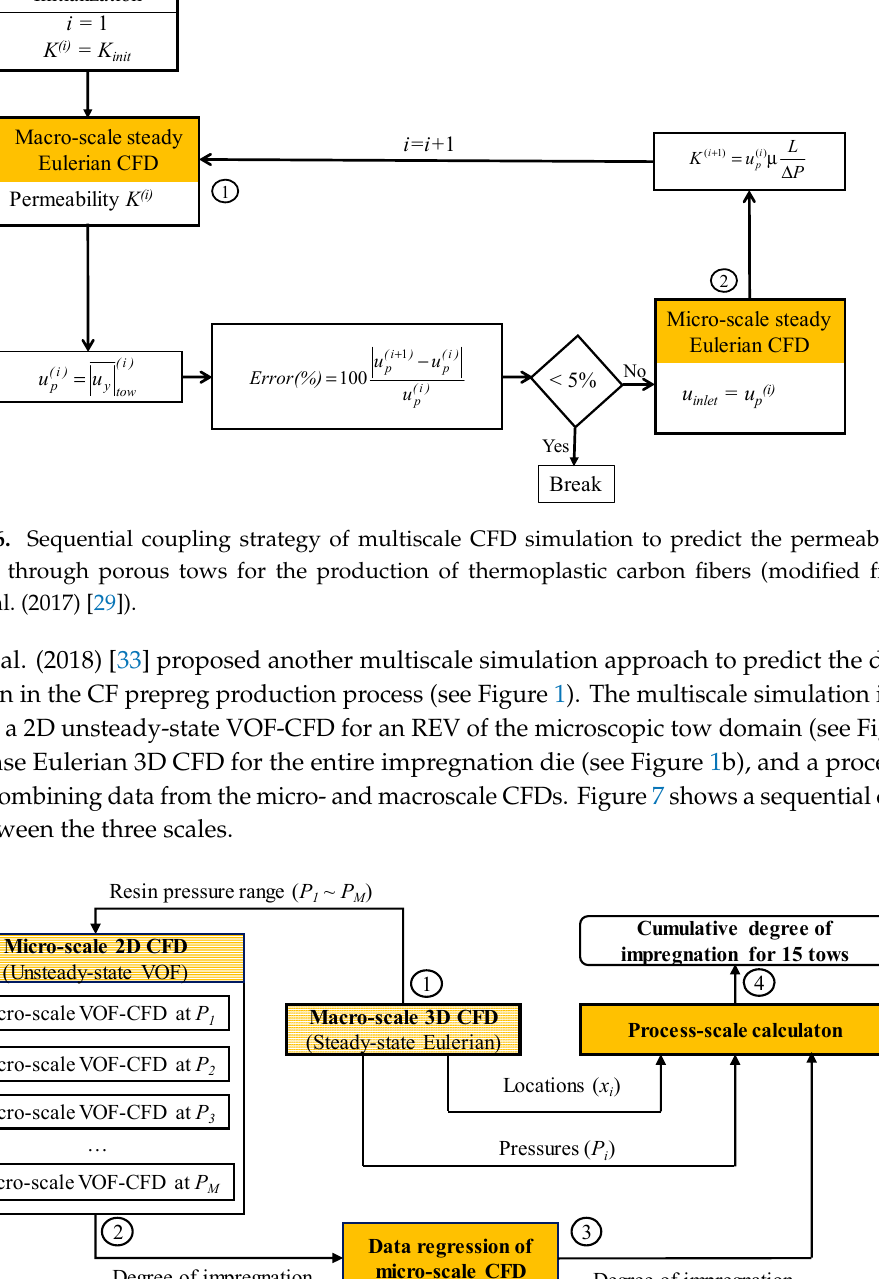
Figure 7. Sequential coupling strategy of multiscale CFD simulation to predict the degree of resin impregnation for the production of thermoplastic carbon fiber (modified from Ngo et al. (2018) [33]). In gas-solid fluidization systems, several multiscale concepts for the Eulerian CFD model have been proposed: a filtered drag force (FDF) model using constitutive equations from highly resolved subgrid models [103], a mesoscale structure-based drag model, where the flow structure and stability conditions were considered to capture the clustering behavior of solid particles using the EMMS model [46,73,104,105], and a CSD drag model [87,100]. Lu et al. (2019) and Wang (2020) [46,47] reviewed several sequential coupling strategies between the EMMS drag and Eulerian CFD models to speed up the multiscale simulation using a lookup table [105] or a fitting function [104] of the drag force. Figure 8 shows the sequential coupling strategy of the multiscale Eulerian CFD with EMMS in fluidized beds. The flow regime with superficial velocity ( 𝑢 (cid:3034) ) and solid flux ( 𝐺 (cid:3046) ), solid material property with particles density ( 𝜌 (cid:3043) ) and diameter ( 𝑑 (cid:3043) ), and a broad range of flow conditions with the Reynolds number ( 𝑅𝑒 ) and voidage ( 𝜀 ) are used as the input values of the EMMS model for generating a fitting function of the heterogeneity index ( H D ) that is directly multiplied by the original Wen and Yu drag force [104].